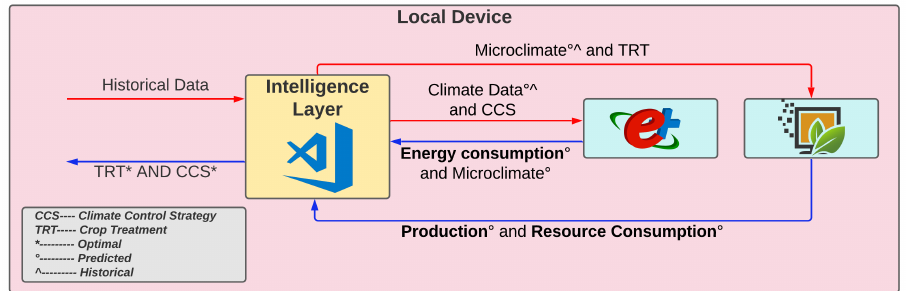
Figure 5. Optimization workflow: Communication between the intelligent layer and the DTs for the optimization of the productivity. Production and energy and resource consumption are indicated in bold since they are utilized for the calculation of the productivity. In the figure, climate data indicate the set of microclimate and environmental